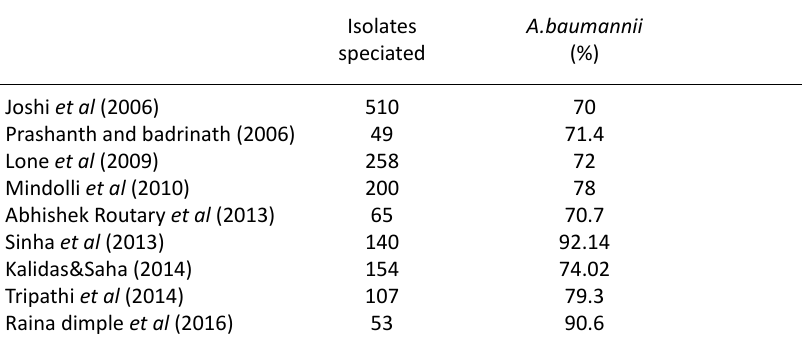
Table 1. A.baumannii isolated in various studies